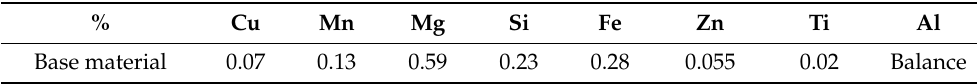
Table 1. Chemical composition of the base material (mass. %).